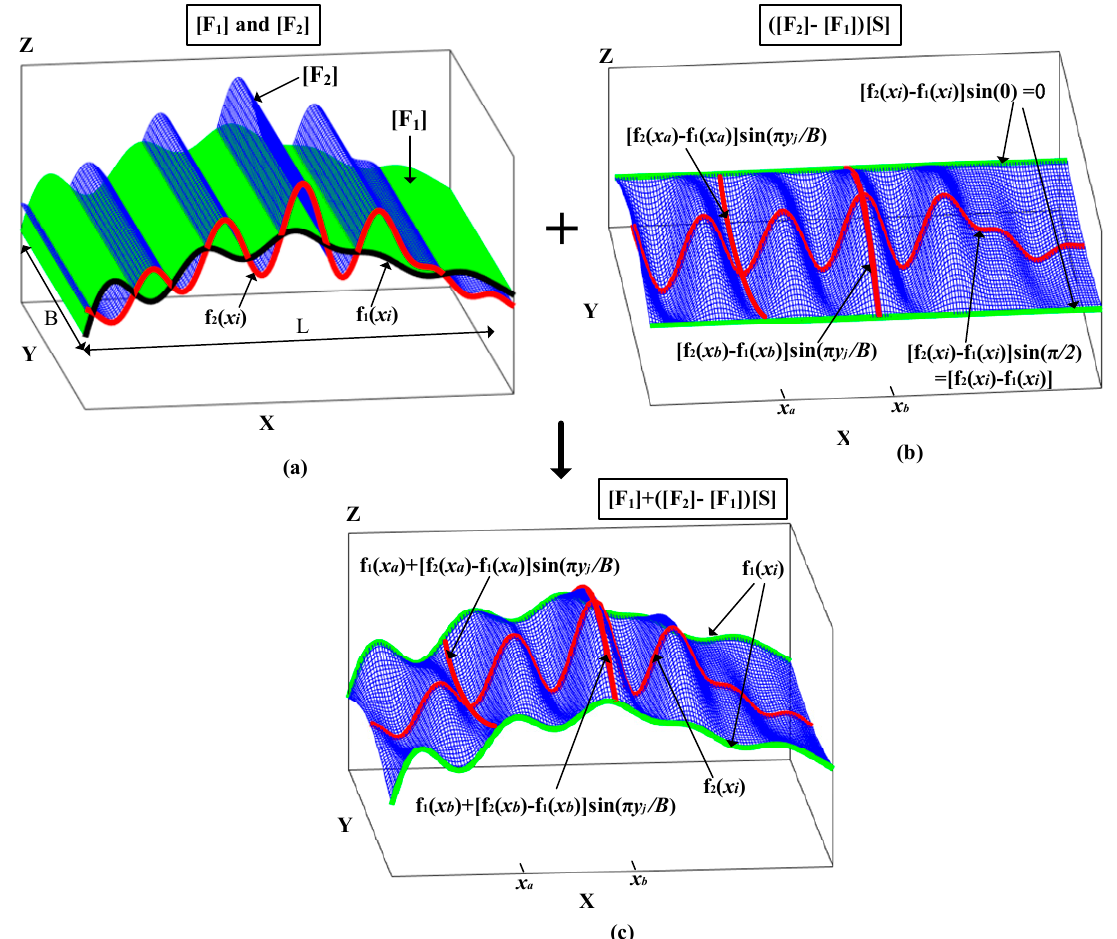
Figure 7. Development of 3D surface with random ω . ( a ) Two surfaces determined by [F 1 ] and [F 2 ]; ( b ) surface determined by ([F 2 ] − [F 1 ]) [S]; ( c ) surface determined by [F 1 ] + ([F 2 ] − [F 1 ]) [S].